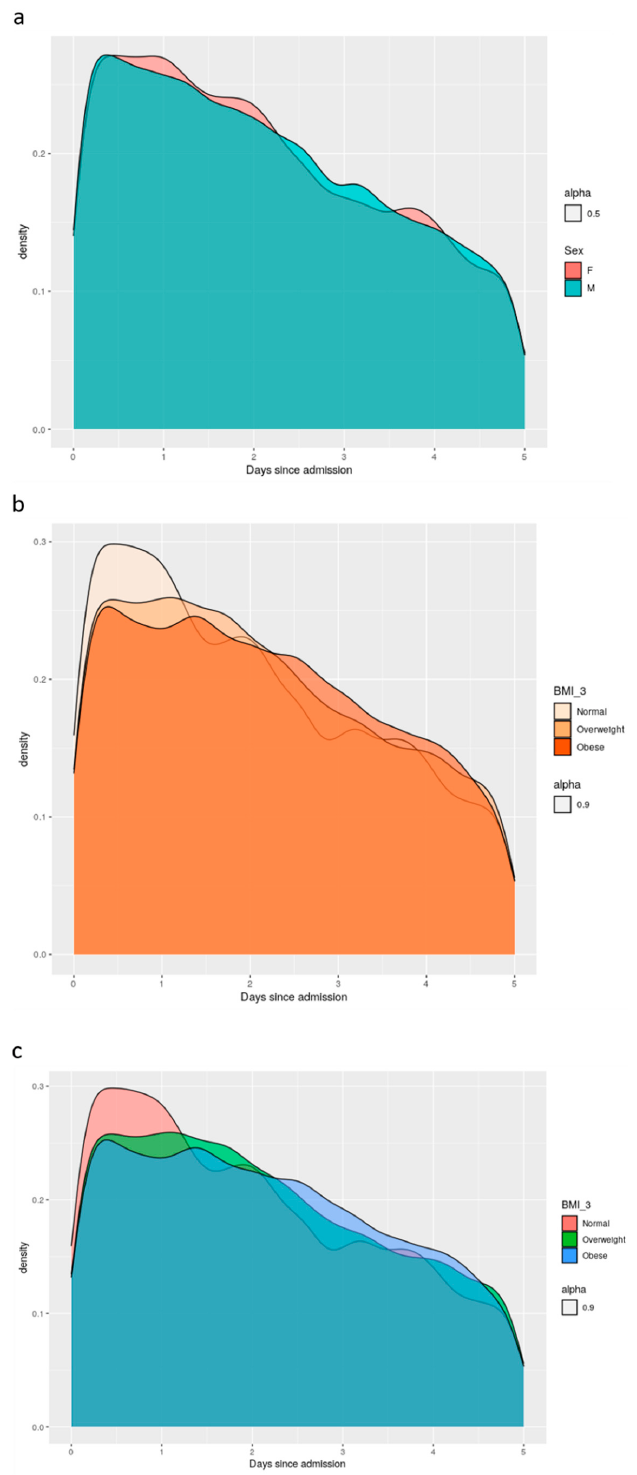
Figure 2. The number of subjects per group throughout the entire monitoring period. ( a ) division by sex; ( b ) division by age groups (young: 18–40 years; middle age: 40–60 years; elderly: 60–80 years; >80 years); ( c ) division by body mass index (BMI; normal weight: <24.9 kg · min − 2 ; overweight: 25–29.9 kg · min − 2 ; obese: >30 kg · min − 1 ). The breakdown of patients’ numbers by day was 492 at 24 h, 408 at 48 h, 294 at 72 h, 204 at 86 h, 130 at 120 h, 92 at 144 h, 66 at 168 h, 49 at 192 h, 43 at 216 h, 33 at 240 h, and 21 at 264